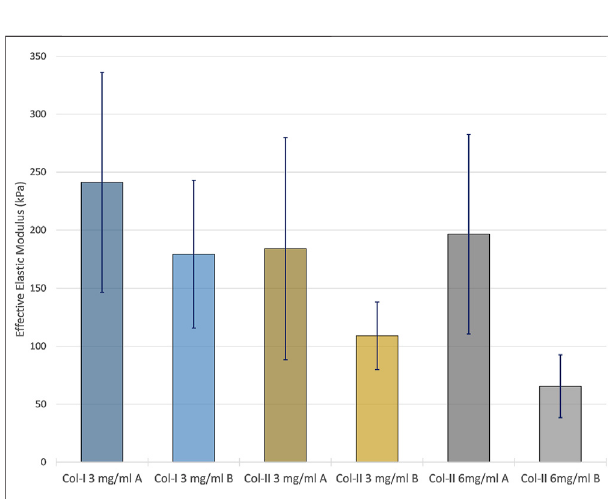
FIGURE 6 | The average effective elastic modulus of each of the sample group measured by nanoindentation using a Hertzian model. Error bars represent the standard deviation of each sample